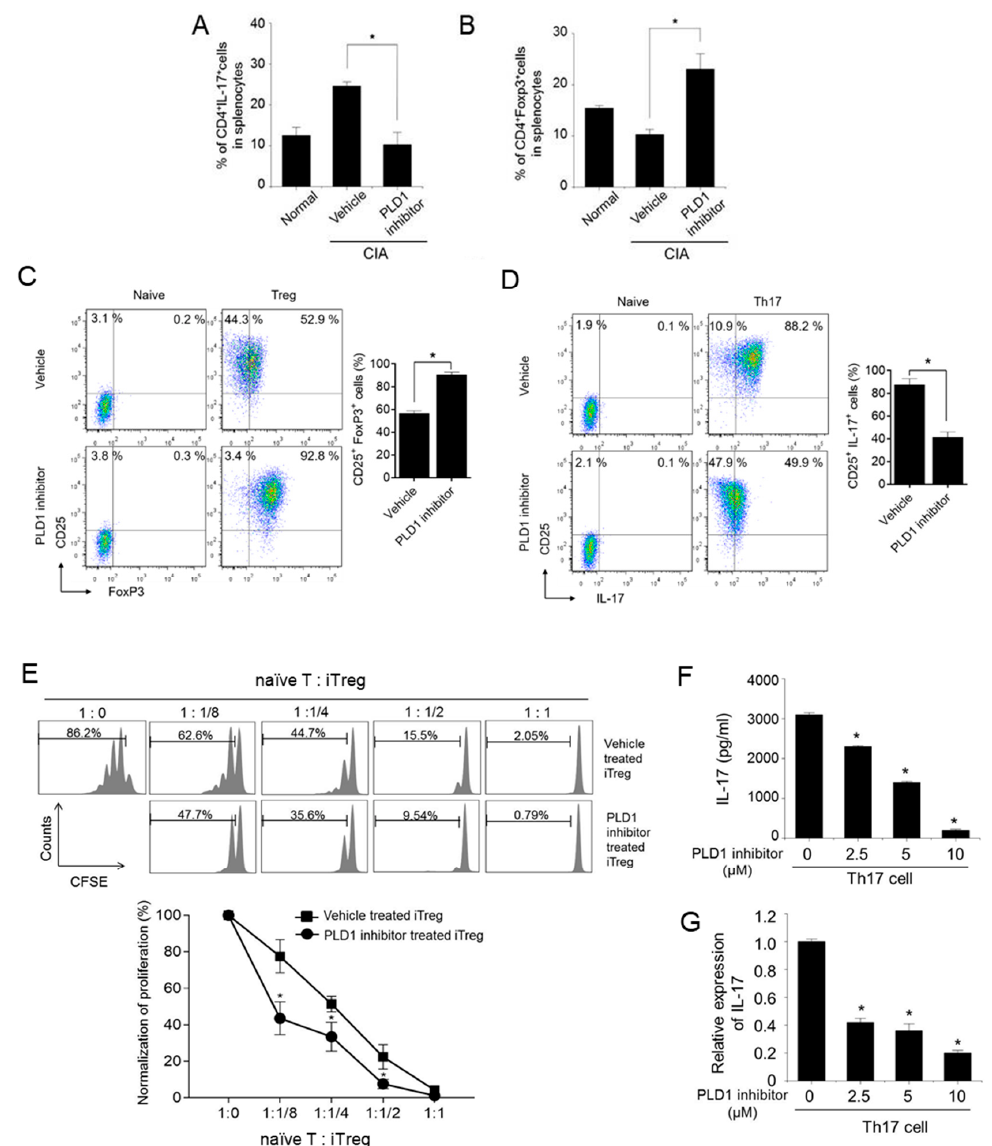
Figure 6. Pharmacological inhibition of PLD1 modulates the Th17 / Treg balance in murine splenocytes. ( A ) E ff ect of the PLD1 inhibitor on the population of CD4 + IL-17 + cells in the spleens of the indicated mice. ( B ) E ff ect of the PLD1 inhibitor on the population of CD4 + Foxp3 + cells in the spleen of mice with CIA. ( C , D ) E ff ect of the PLD1 inhibitor on in vitro di ff erentiation of Treg ( C ) and Th17 ( D ) cells. Naïve CD4 + T cells isolated from mice spleens were cultured under condition of Treg cells or Th17 cell di ff erentiation. Representative flow cytometry profile and quantification for CD25 + Foxp3 + Treg and CD25 + IL-17 + Th17 cell populations. ( E ) Freshly isolated naïve CD4 + T cells (naïve T cells), labeled with CFSE were cocultured in the presence of anti-mouse CD3 ε and anti-mouse CD28 for 72 h with induced Treg cells (iTreg) generated in the presence or absence of the PLD1 inhibitor. Proliferation of naïve CD4 + T cells was analyzed by flow cytometry for CFSE dilution. ( F , G ) E ff ect of the PLD1 inhibitor on the secretion ( F ) and expression ( G ) of IL-17 during di ff erentiation of Th17 cells as analyzed by ELISA and q-PCR, respectively. n = 6 per group. * p < 0.05. Results are representative of at least six independent experiments, and shown as mean ± standard error of the mean (SEM).